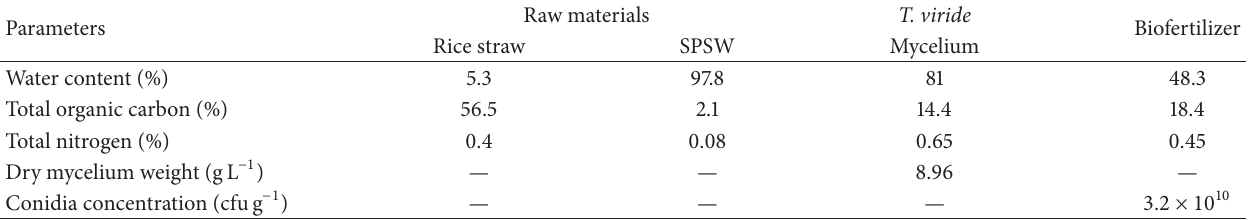
Table 1: Process parameters for bioconversion of SPSW and rice straw into biofertilizer by T. viride .